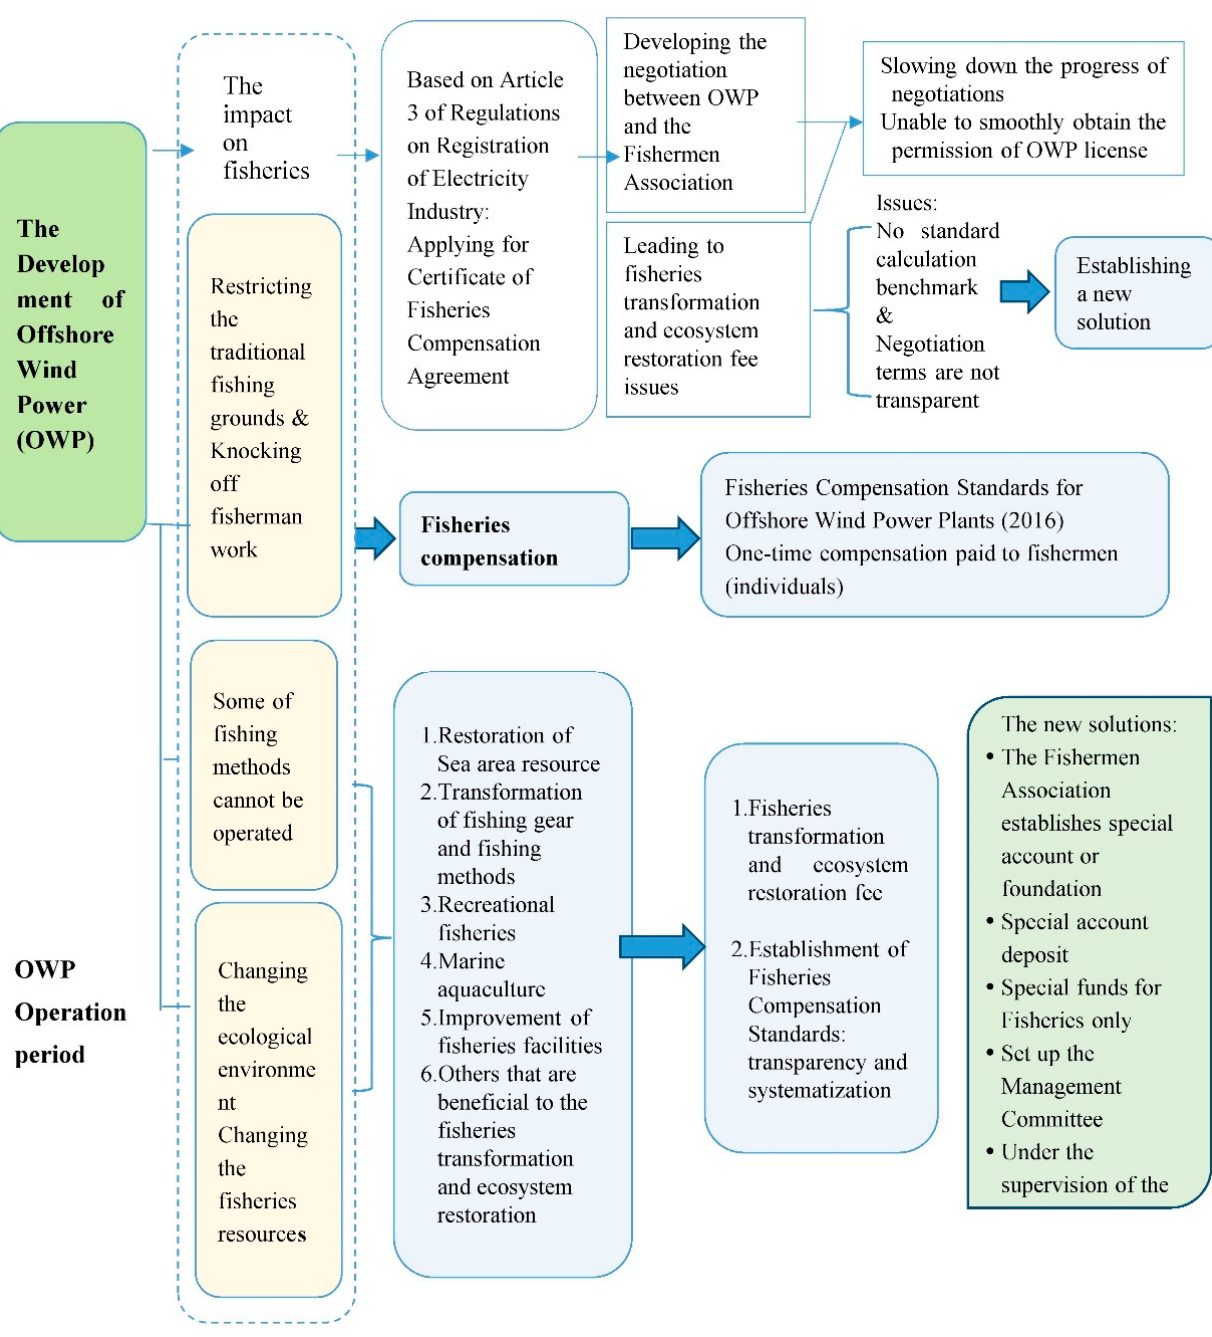
Figure 2. The draft amendment to the Fisheries Compensation Standards for Offshore Wind Power Plants. Source: Authors’ own based on WindTAIWAN (2021) [51].